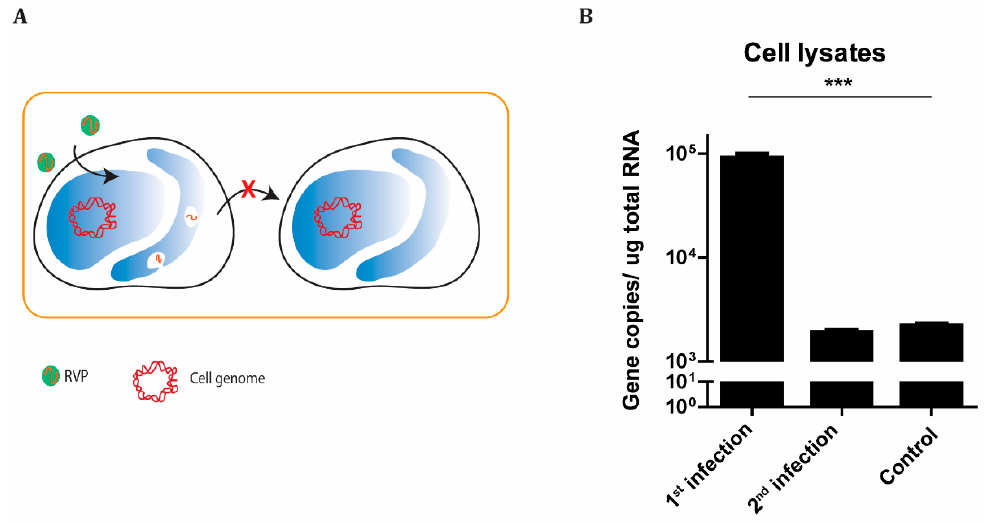
Figure 4. KUNV RVPs infect cells in a single round. ( A ) Schematic illustration of the process of RVP infection of BHK-21 cells. Hereby, the absence of a packaging system in the infected cells limits additional RVP production. ( B ) Gene copy numbers of the KUNV replicon in cell lysates after first- and second-round infection and uninfected control lysates as measured by qPCR. The experiments were conducted independently three times with two technical repeats. The p values are indicated using *** p < 0.001.